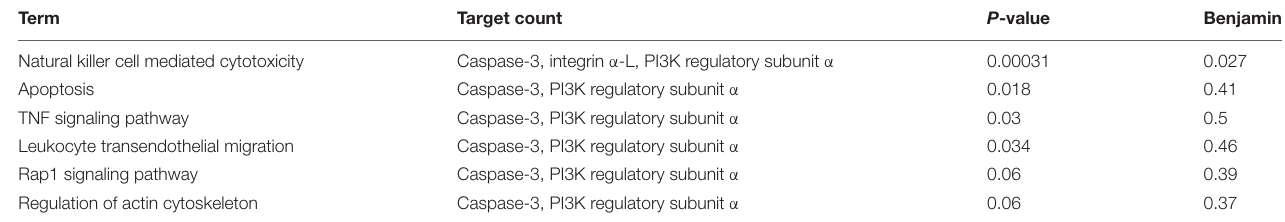
TABLE 3 | Potential pathway of putative